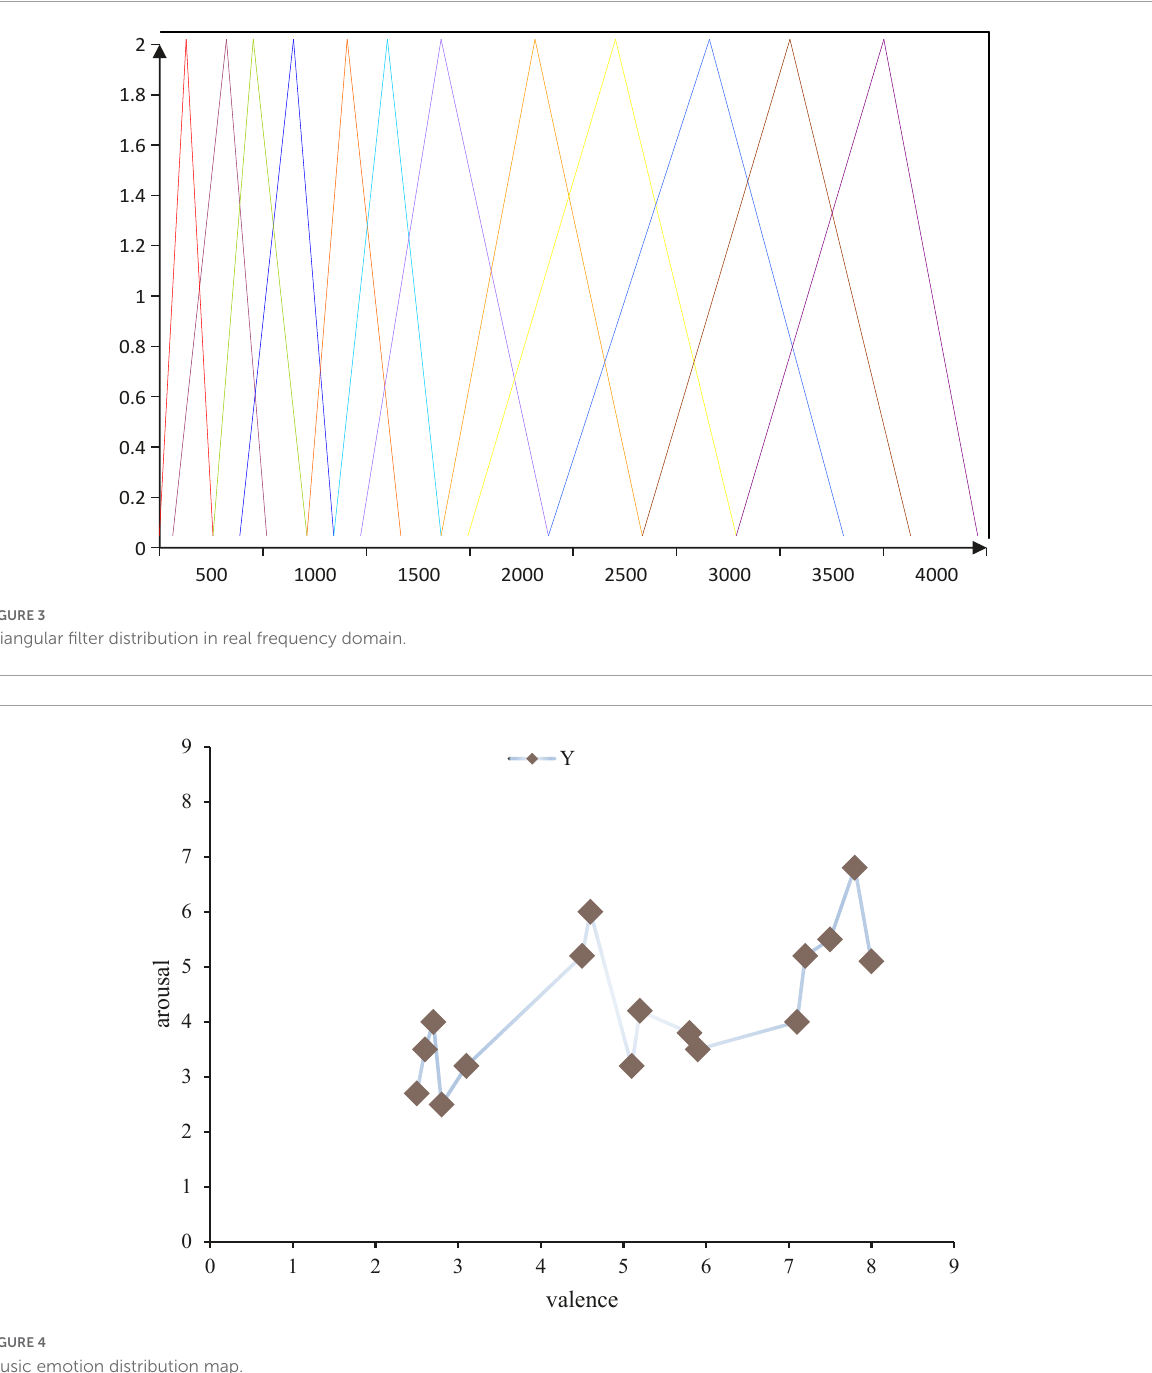
FIGURE4 Music emotion distribution